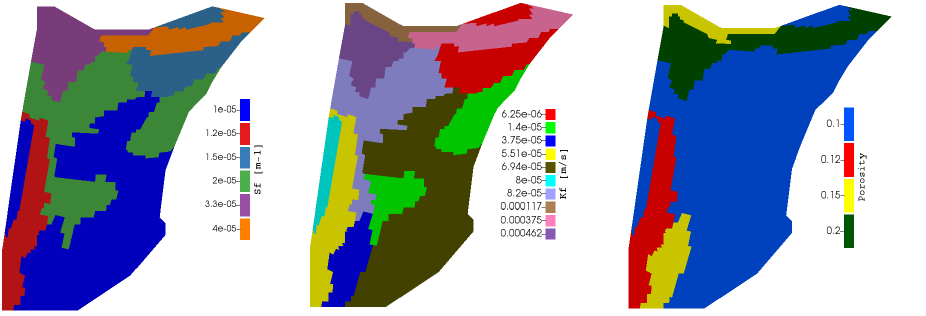
Figure 9. Distribution maps of specific storage coefficient, hydraulic conductivity and porosity, respectively, of the aquifer.